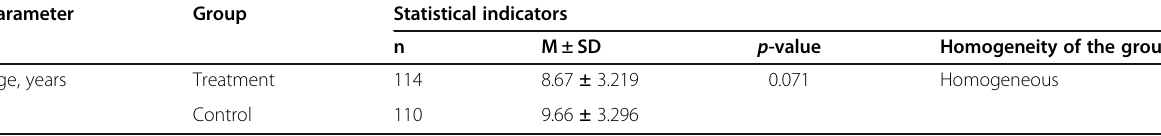
Table 3 Allocation of patients according to age Parameter